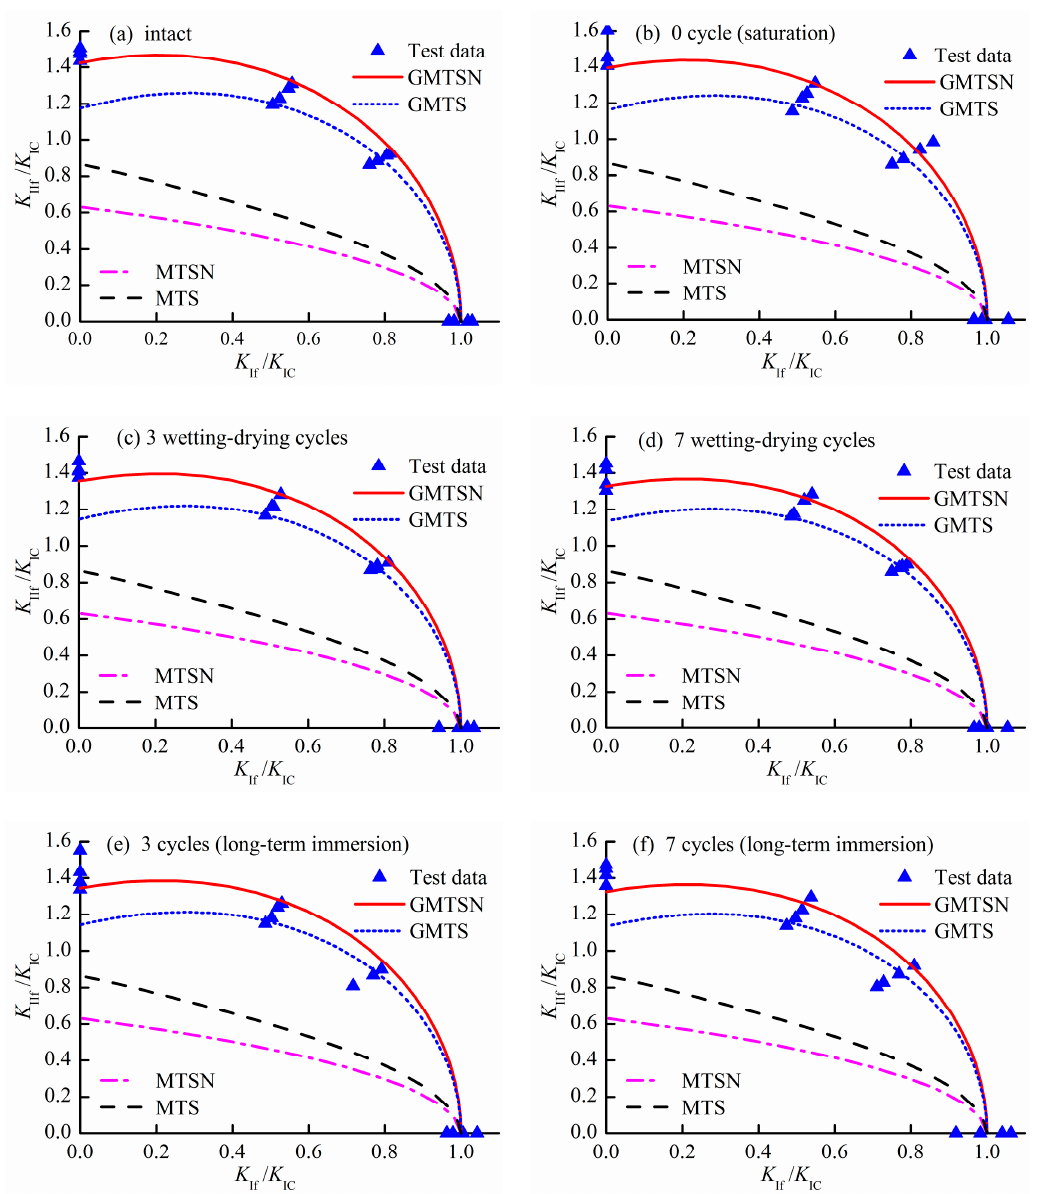
Figure 7. Comparison of the experimental values and theoretical predictions based on the fracture criteria.